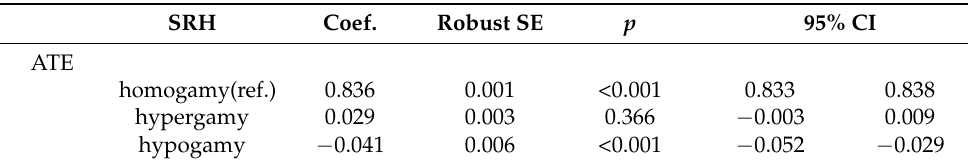
Table 6. Effects of educational assortative mating on health (N =